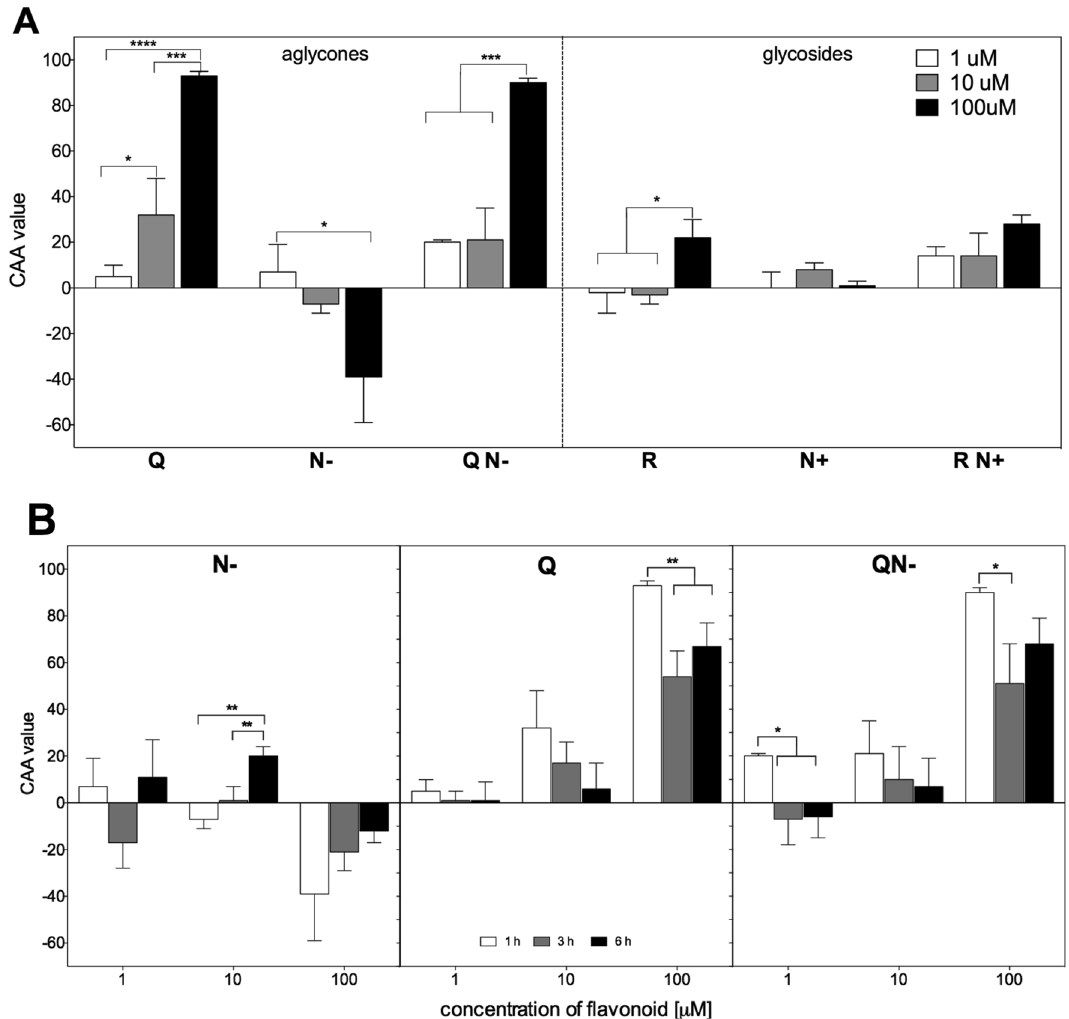
1 h treatment. ( B ) The kinetics of changes in cellular antioxidant activity determined for Q and N− (1–100 μM) and their mixture QN− containing equal concentrations of each compound (1–100 μM) after 1, 3 and 6 h treatment. Results are means ± SD of three independent experiments carried out in triplicates. Significantly different values determined by one-way ANOVA with Tukey’s test are marked as: * p ≤ 0.05, ** p ≤ 0.01, *** p ≤ 0.001, **** p ≤